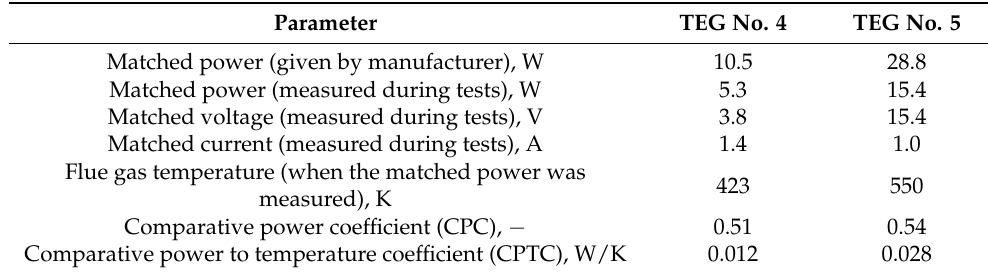
Table 2. Comparative power coefficient and comparative power to temperature coefficient.